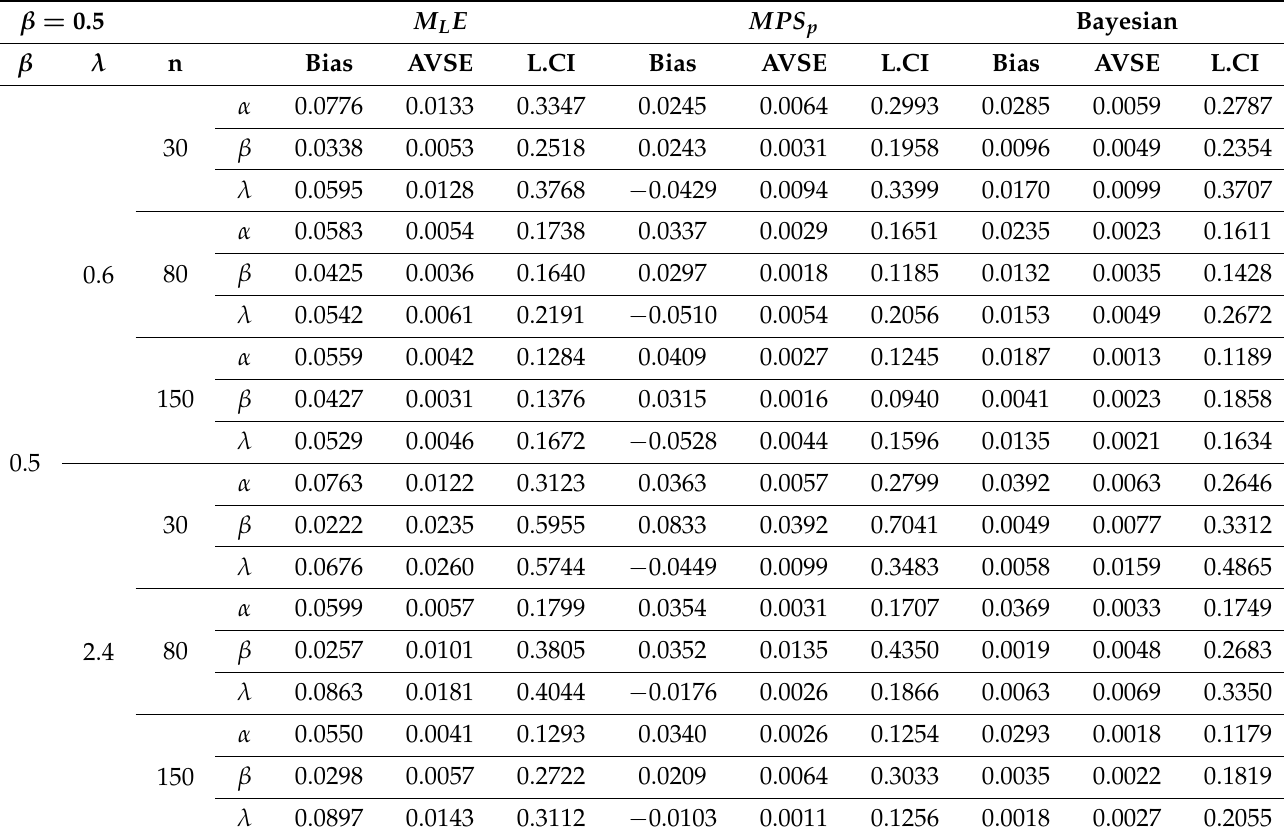
Table 16. M L E , MPS p and Bayesian estimation methods for parameters of UEPD for β = 0.5. β =